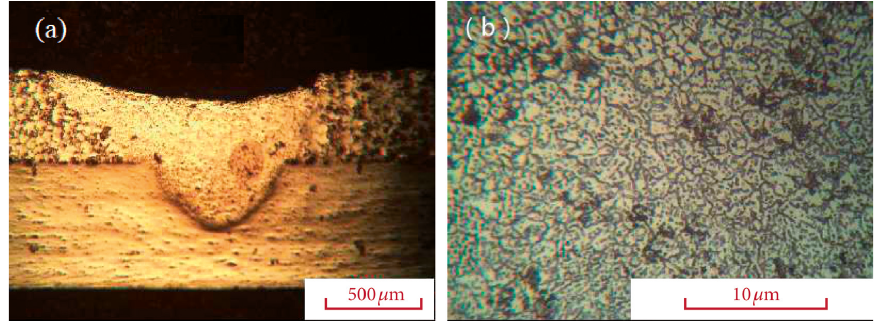
Figure 2: Microstructure of welding joint. (a) Cross section. (b) Microstructure of the fusion zone.